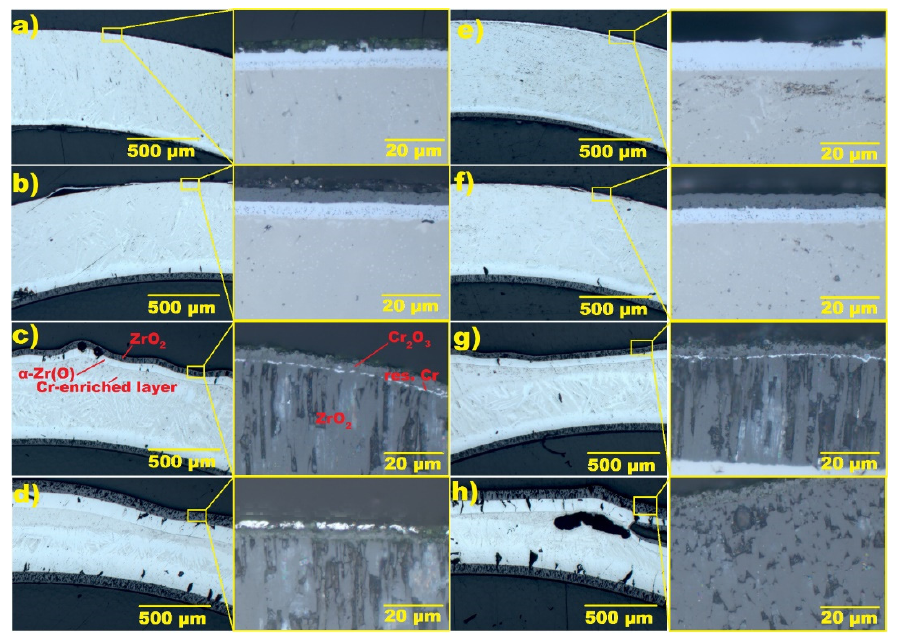
Figure 12. Optical images of the cross-section microstructure of the ZrO 2 /Cr-100 ( a – d ) and ZrO 2 /Cr ( e – h ) samples after steam oxidation at 1250 ◦ C (120 and 300 s), 1330 ◦ C (120 s), and 1400 ◦ C (120 s),